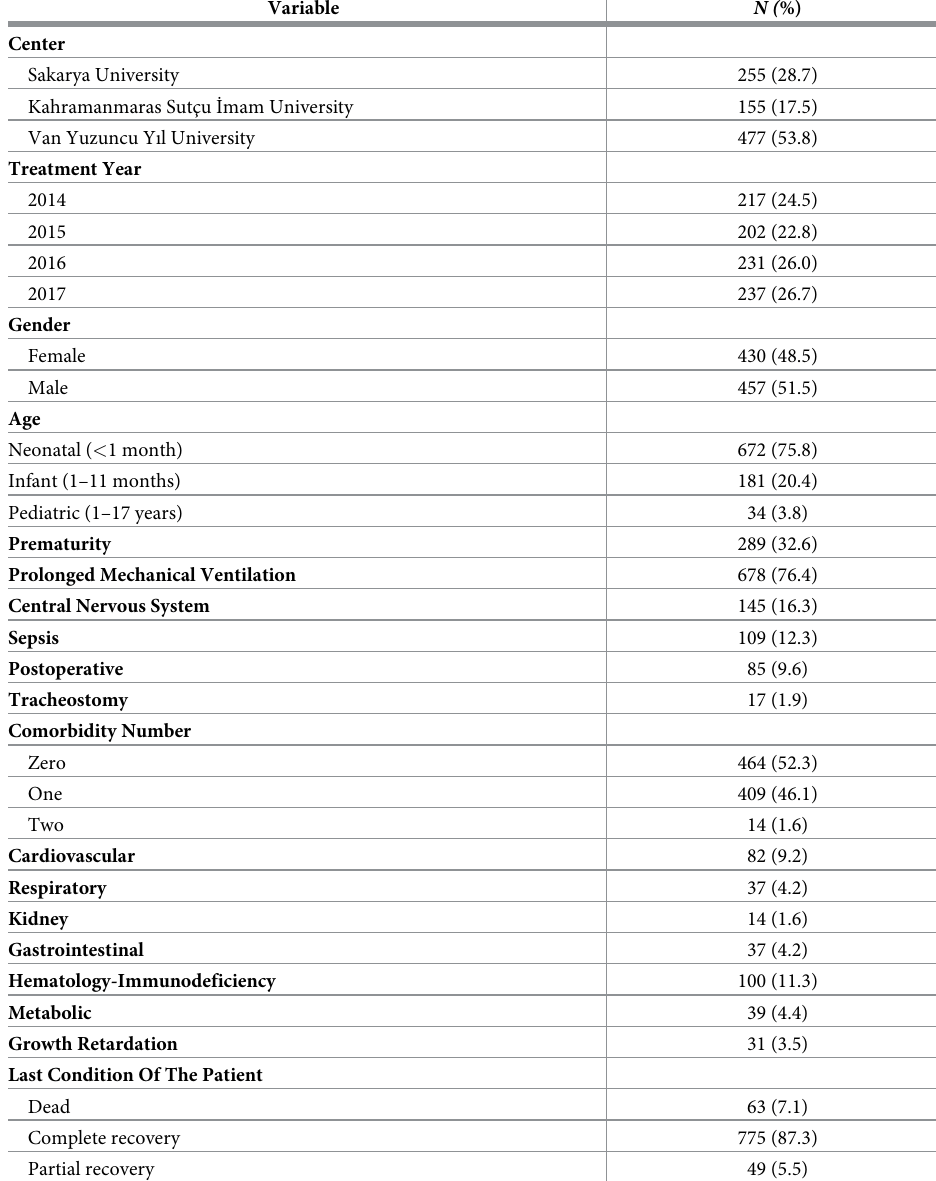
Table 1. Demographic characteristics of pediatric chronic critical patients for